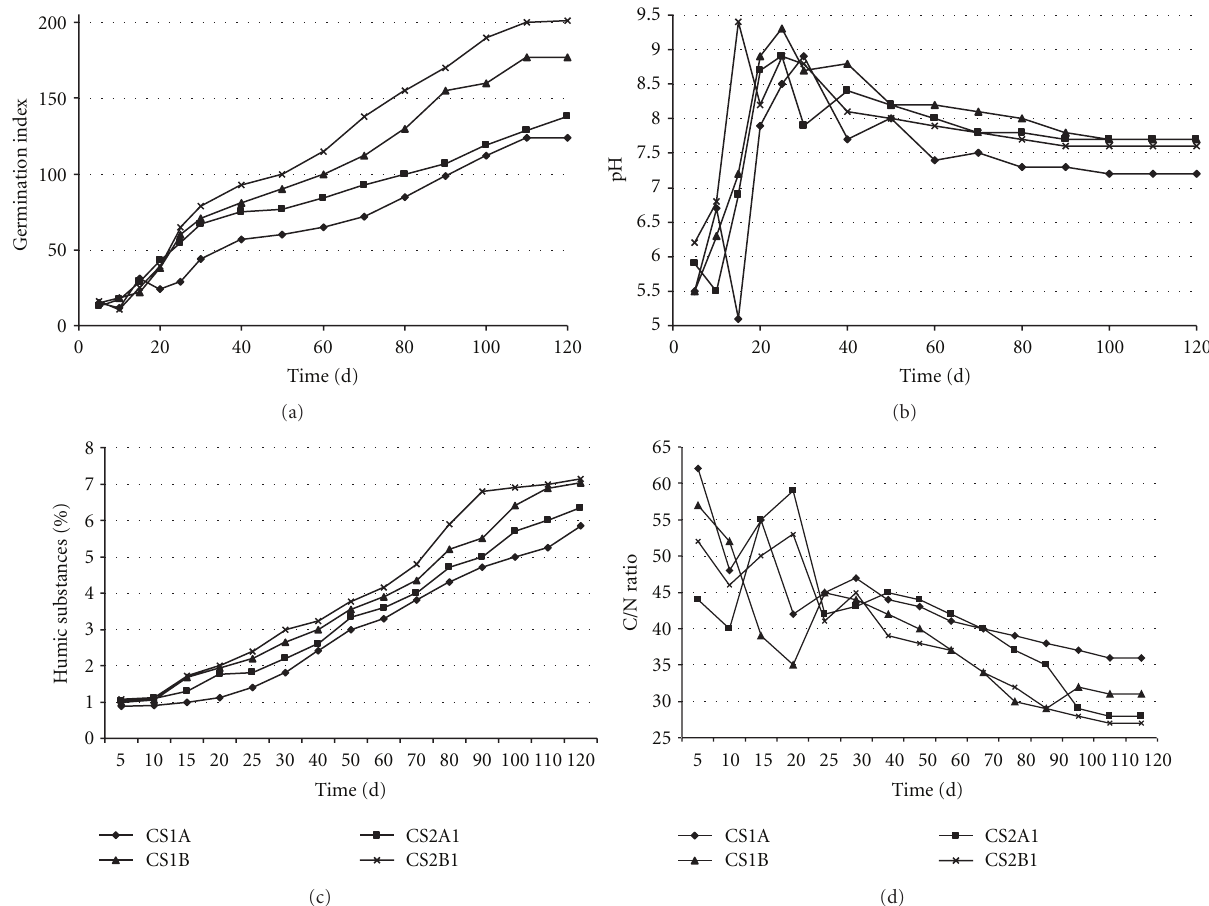
Figure 2: (a) Germination index during the composting process of the two several compost systems. Refer to Section 2.3 for treatment codes. (b) pH variation, during the composting process of the two several compost systems. Refer to Section 2.3 for treatment codes. (c) Humic substances variation, during the composting process of the two several compost systems. Refer to Section 2.3 for treatment codes. (d) C/N ratio variation during the composting process of the two several compost systems. Refer to Section 2.3 for treatment codes. is initially low, due to the acid formation (pH < 5.5)